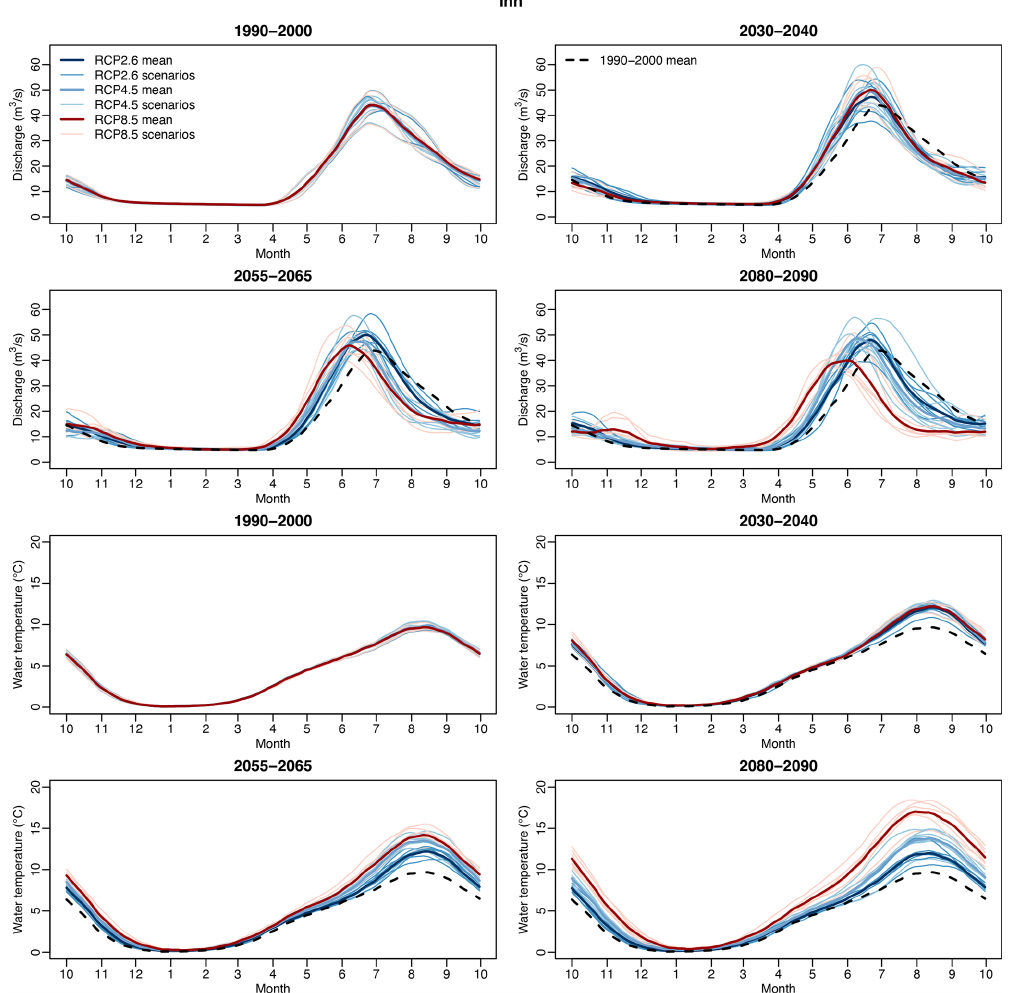
Figure 7. Annual cycle of discharge (top panels) and river temperature (bottom panels) of the Inn catchment. The cycles are obtained by computing the average for each day of the year and by applying a circular moving average of 30d. Dark lines show the mean for each RCP over each period, and light lines show individual scenarios. Black dashed lines indicate the mean over the reference period 1990–2000 (only shown in subsequent periods to ease